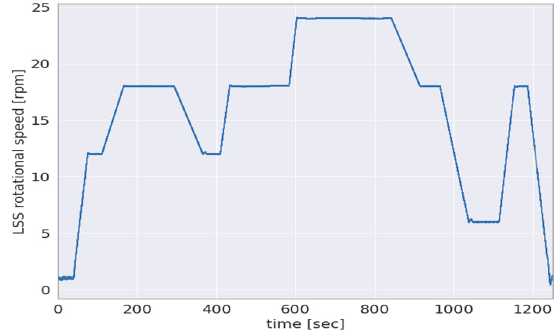
Figure 8. Rotational speed in rpm of the LSS in multiple-load test scenario.